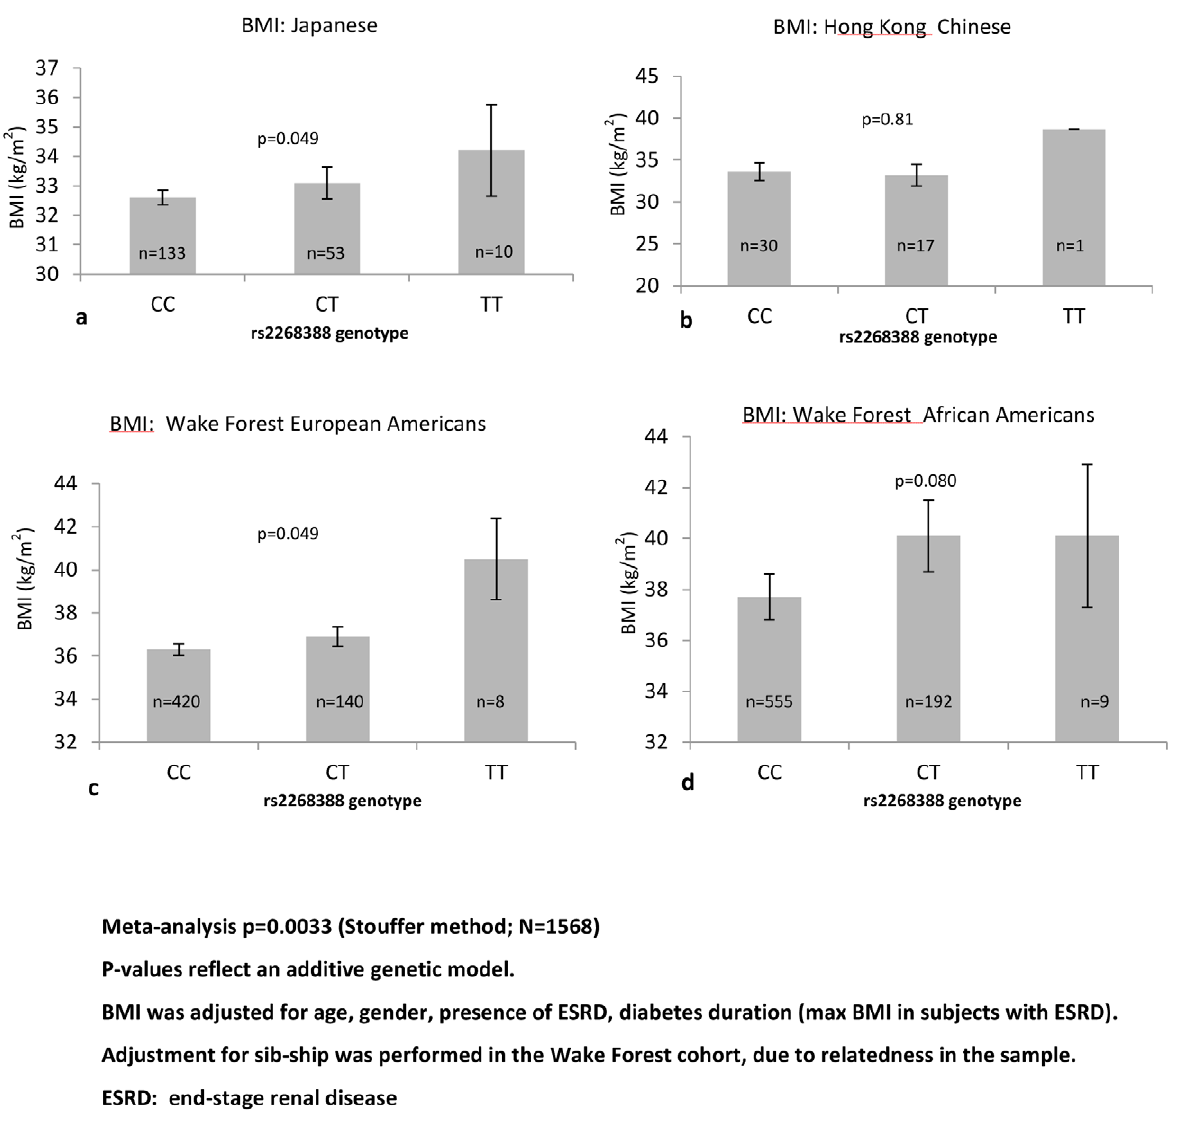
Figure 2. Association of rs2268388 with BMI in subjects with type 2 diabetes and BMI $ 30 kg/m 2 .